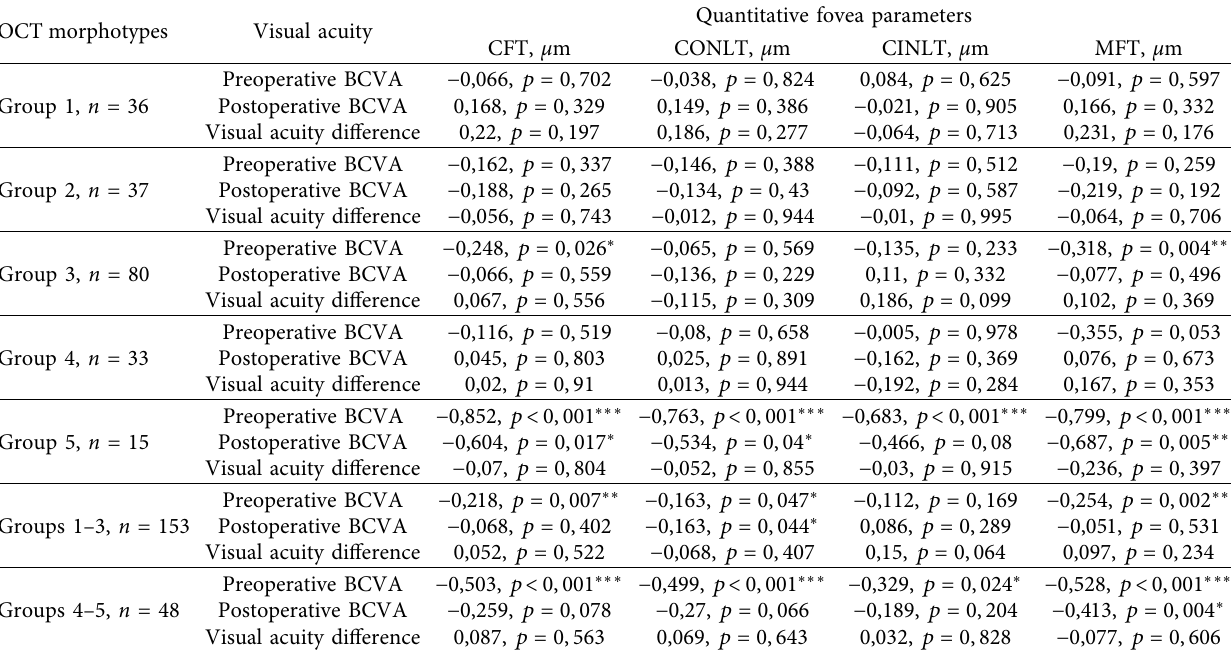
Table 4: Pearson’s correlations ( R 2 ) between quantitative fovea parameters in OCT morphotypes of ERM, pre- and postoperative BCVA, and postoperative visual acuity difference with designation of the corresponding significance level ( p value). ∗ p < 0 , 05, ∗∗ p < 0 , 01, and ∗∗∗ p < 0 , 001.